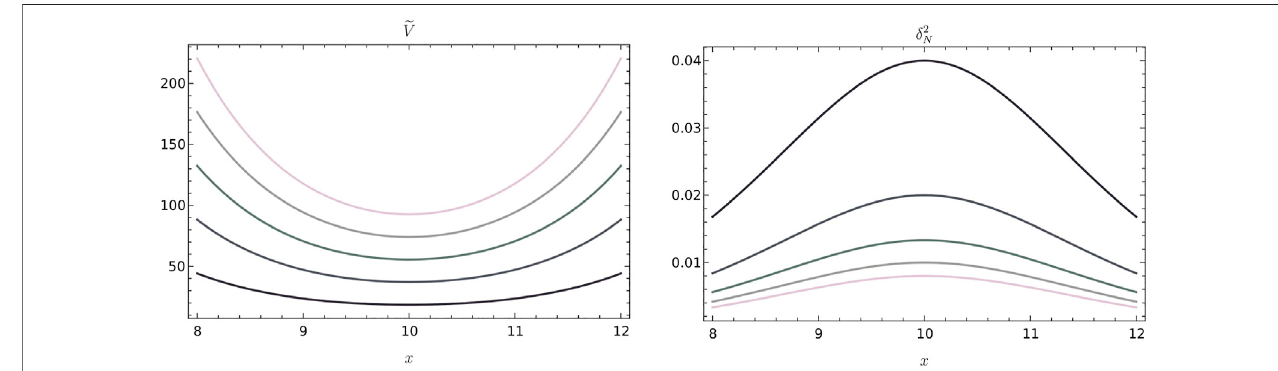
FIGURE 1 | Plots of the dimensionless volume operator ~ V ≡ V / L Pl and of the relative variance of the number operator δ 2 N as functions of x (cid:2) 2 μ χ 0 in a two-spin scenario with j 1 (cid:2) 1 / 2 and j 2 (cid:2) 1. The plots are obtained with μ j integer steps. Darker (lighter) lines correspond to smaller (higher) values of c .